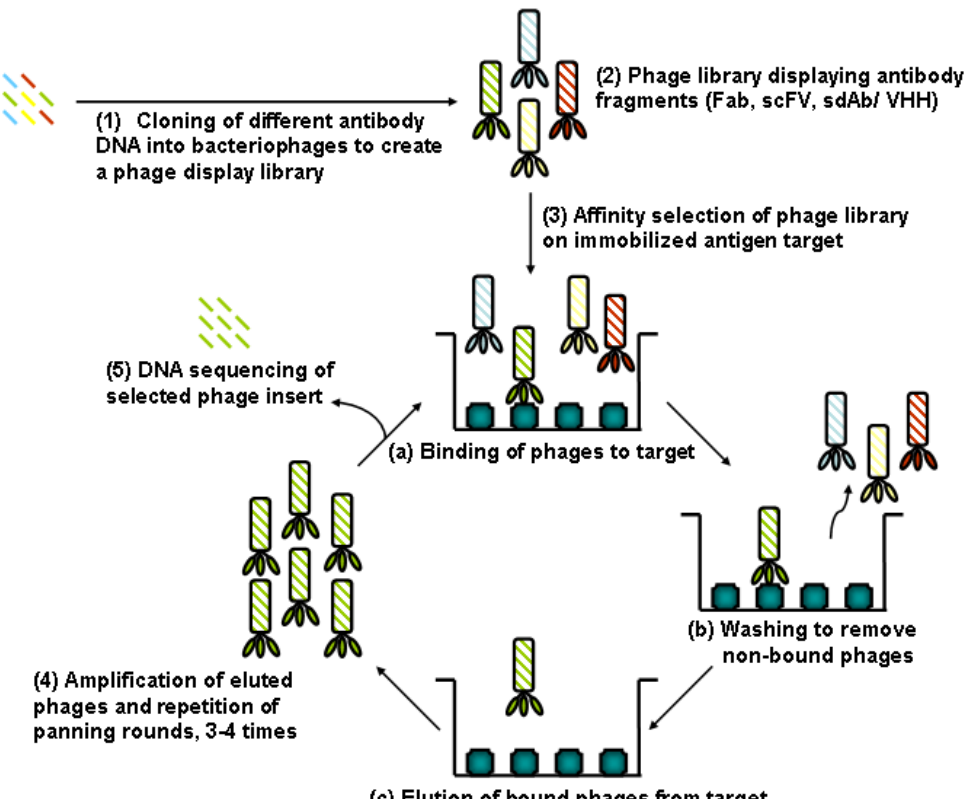
Figure 3. Schematic showing steps involved in affinity selection to isolate target analyte specific antibody (Ab) fragments (Fab, scFv or sdAb/VHH) from an antibody phage display library: (1) DNA encoding millions of different Ab fragments (Fab, scFv or sdAb) is cloned into the genome of filamentous bacteriophage linked to one of the phage coat protein genes; (2) Each DNA variant is packed into a separate phage particle, and the Ab fragment displayed on the phage coat protein; (3) Phage displaying Fab, scFv or sdAb that bind to the target analyte are selected using biopanning cycles of (a) binding, (b) washing, and (c) elution; (4) Eluted phages are reinfected into E. coli cells and amplified for further rounds of affinity selection; (5) Clones from the enriched library are characterized for binding properties using appropriate